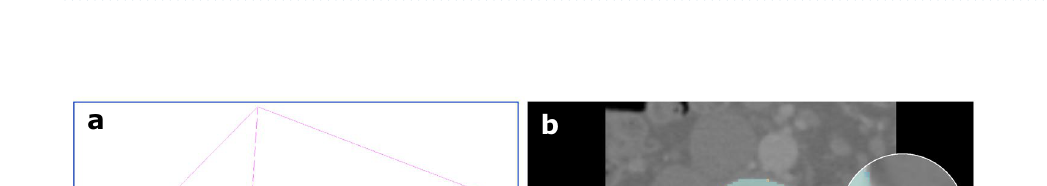
Table 5. Comparison of location errors on thoracic and lumbar.